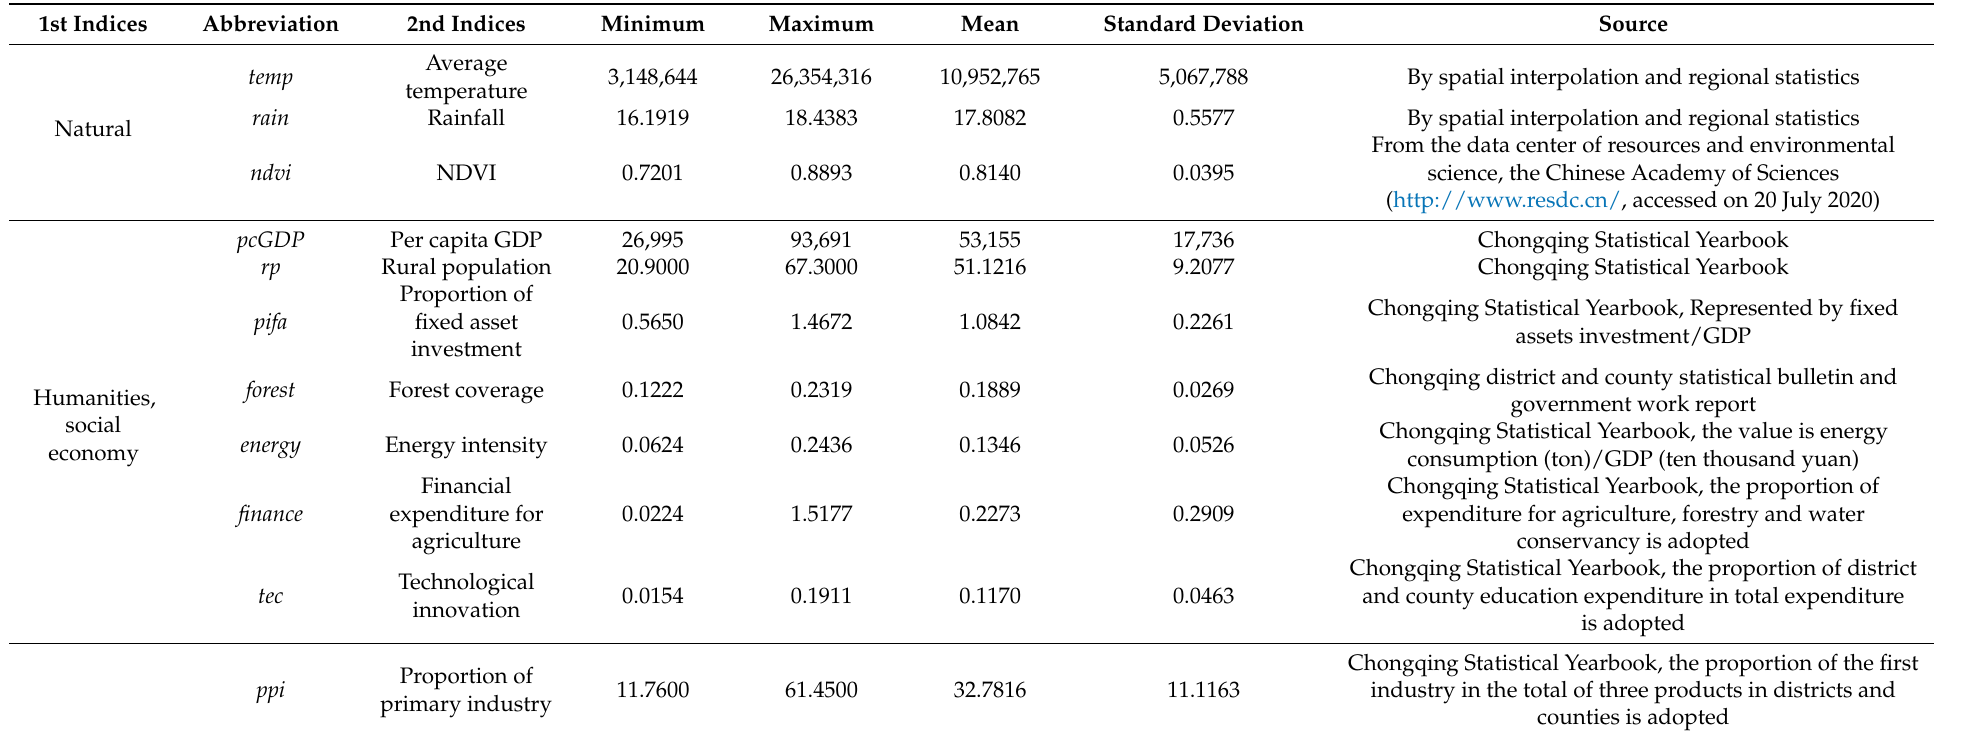
Table 2. Evaluation index system of influencing factors of